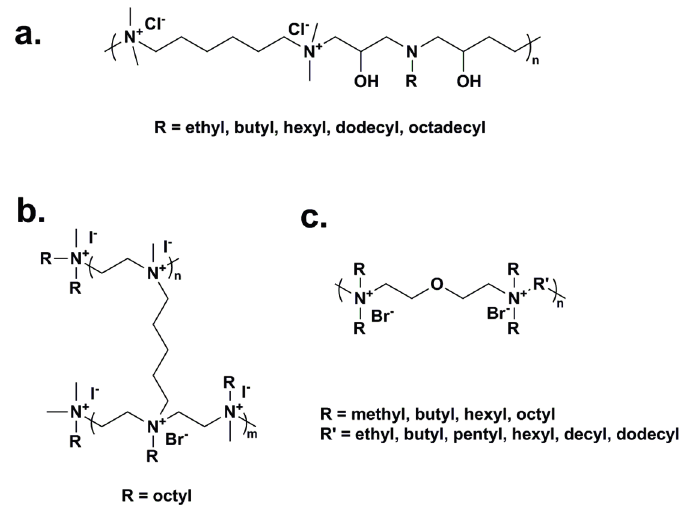
Figure 3. ( a ) Comb-like ionenes with aliphatic side chains, adapted from [76]; ( b ) Polyethyleneimine (PEI)-based ionenes for preparation of dental composites, adapted with permission from [78]; ( c ) Alkyloxyethylammonium ionenes, adapted with permission from